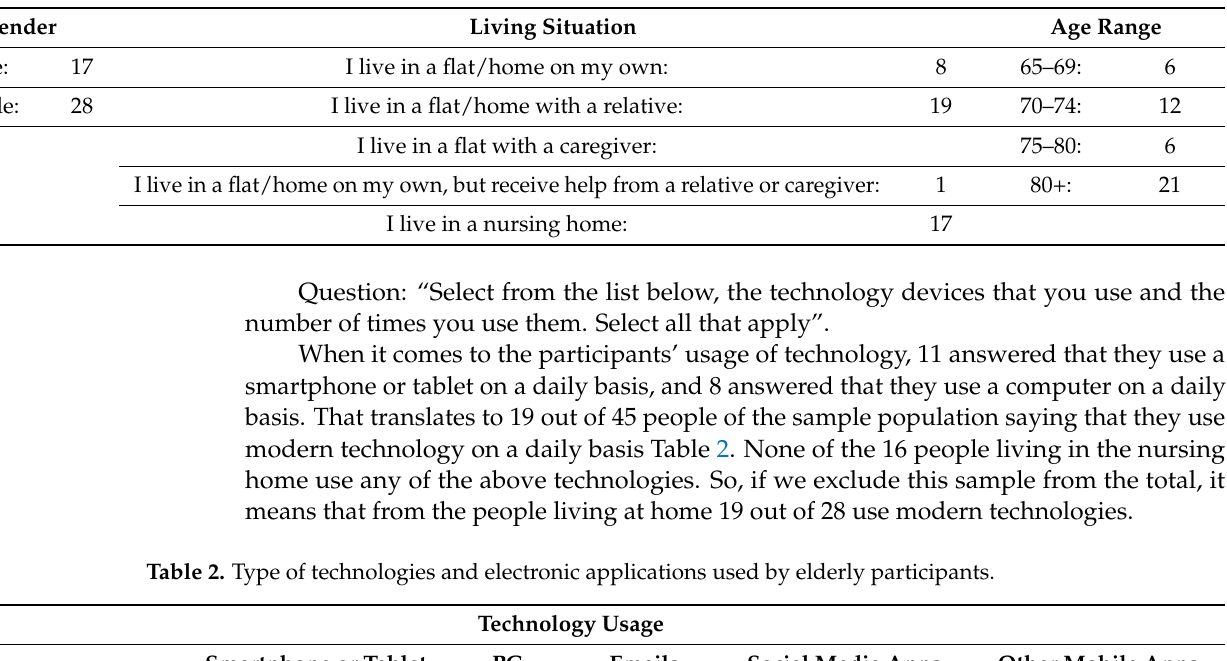
Table 1. Characteristics of elderly participants.